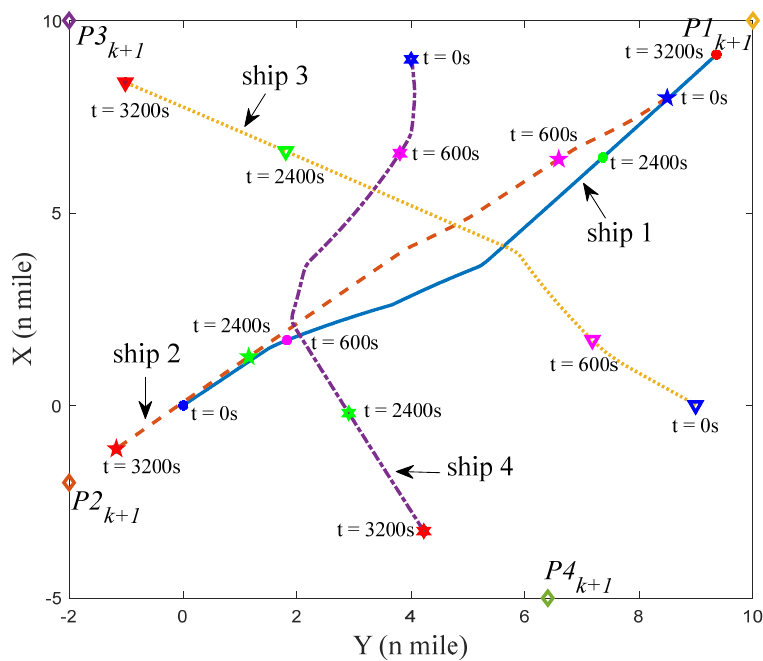
Figure 9. The situation of four ships at t = 2400 s in scenario 1.